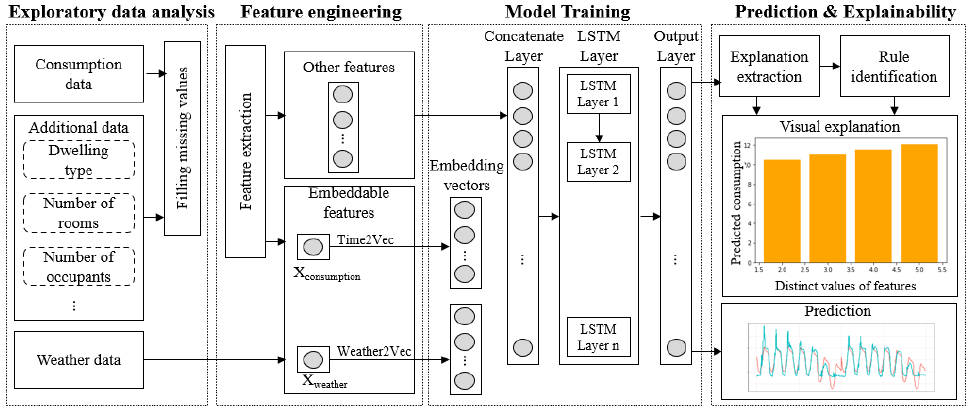
Figure 1. The overall architecture of the proposed